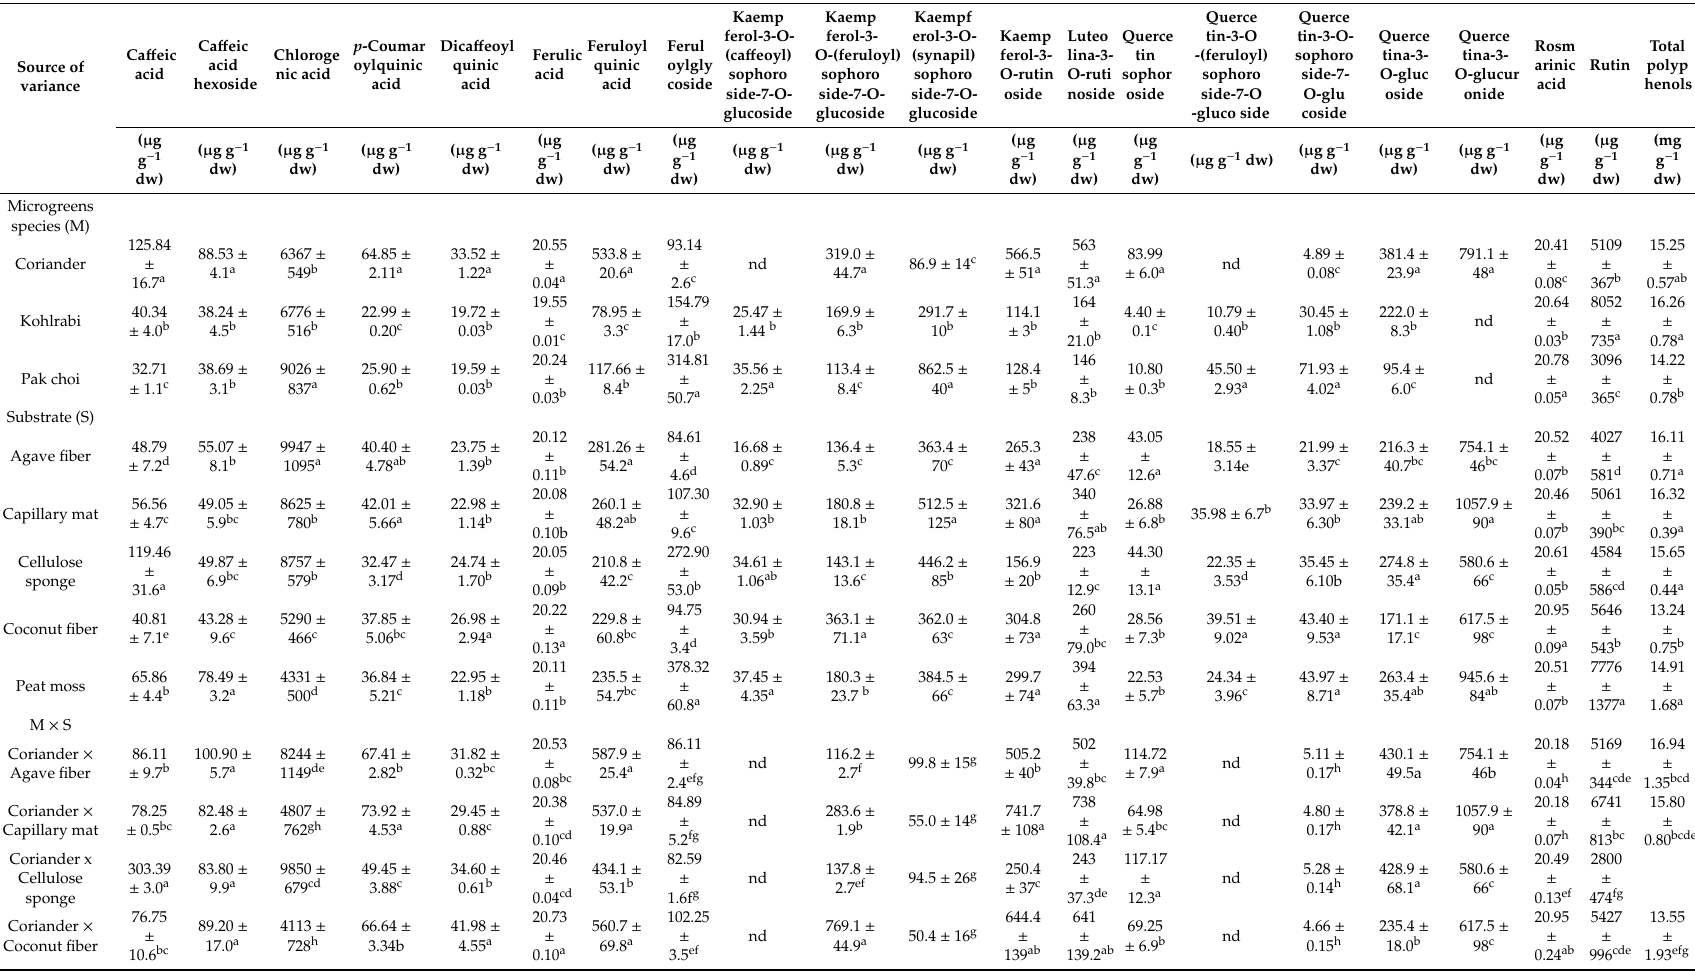
Table 5. Phenolic composition of coriander, kohlrabi and pak choi substrates grown on natural fiber and synthetic substrates under a controlled environment. All data are expressed as mean ± standard error, n =